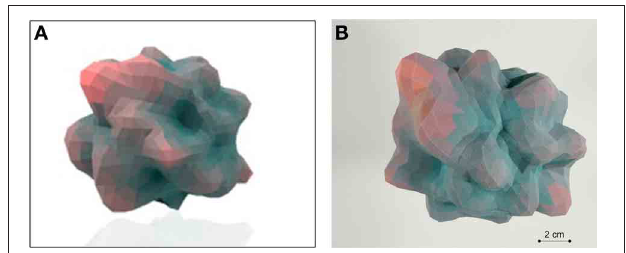
FIGURE 11 | Tangible-user interface outputs for Plurigon . (A) Rendering of an exemplary Plurigon structure from a.wrl format file. (B) Actual physical 3-dimensional print-out of a Plurigon for potential TUI (tangible user interface) applications and topological